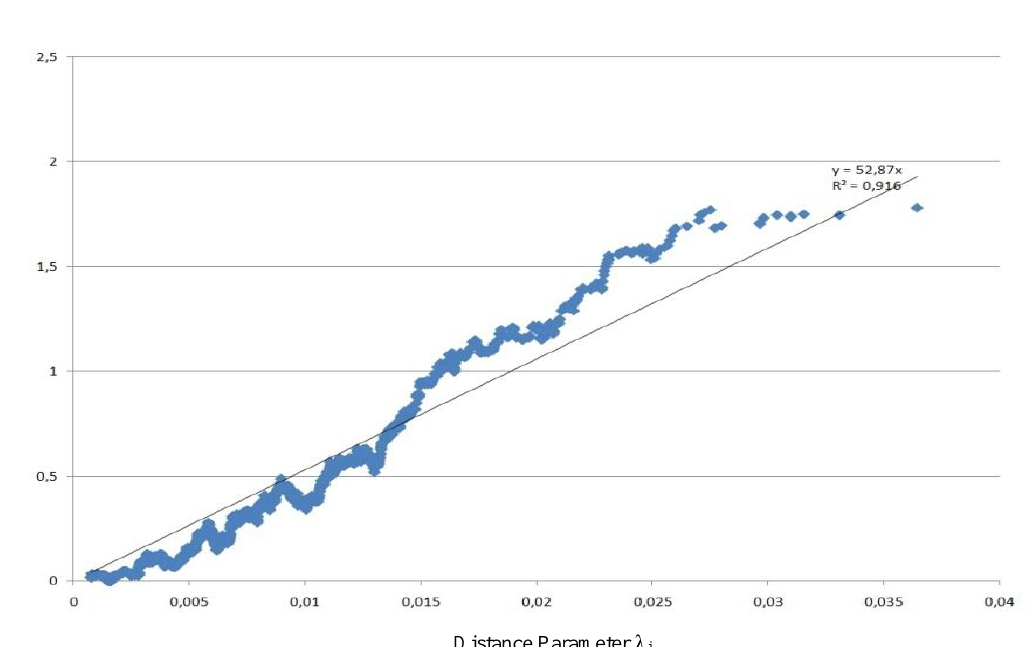
Figure 5. distance parameter vs. expected number of craters per parcel.